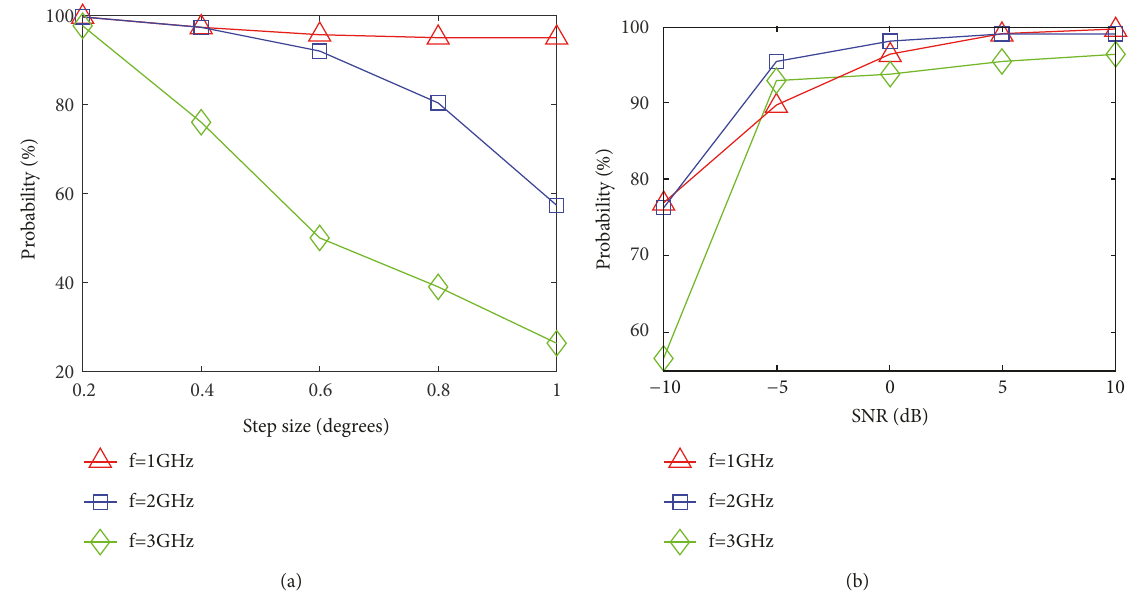
Figure 9: Probability of precise estimation versus step size and SNR. (a) Step size in search (noiseless). (b) SNR (step size = 0.2).